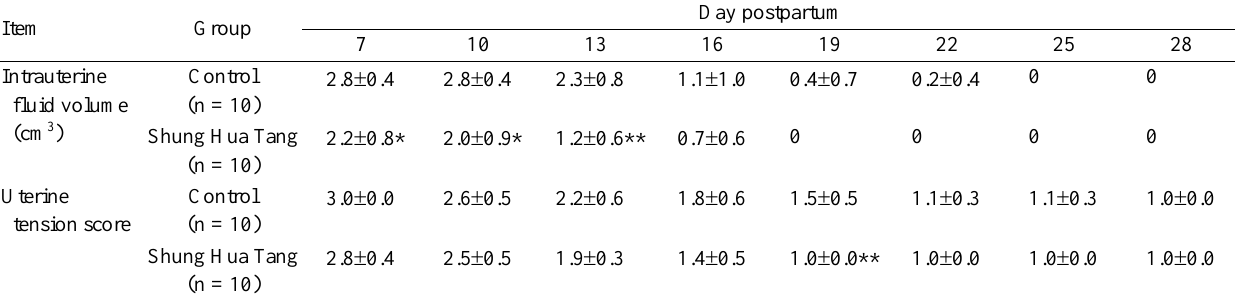
* Means differ significantly between groups (p<0.05). ** Means differ significantly between groups (p<0.01). Table 3. The effects of Sheng Hua Tang treatment on trial cows’ first ovulation periods Item